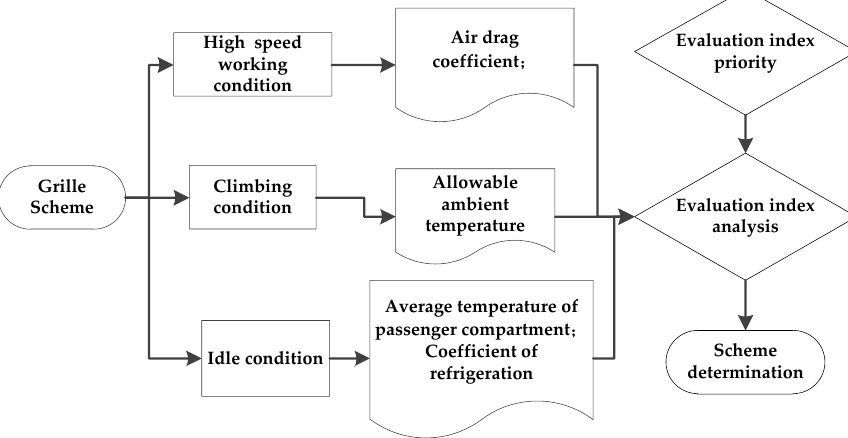
Figure 6. Simulation analysis flow of grille schemes.